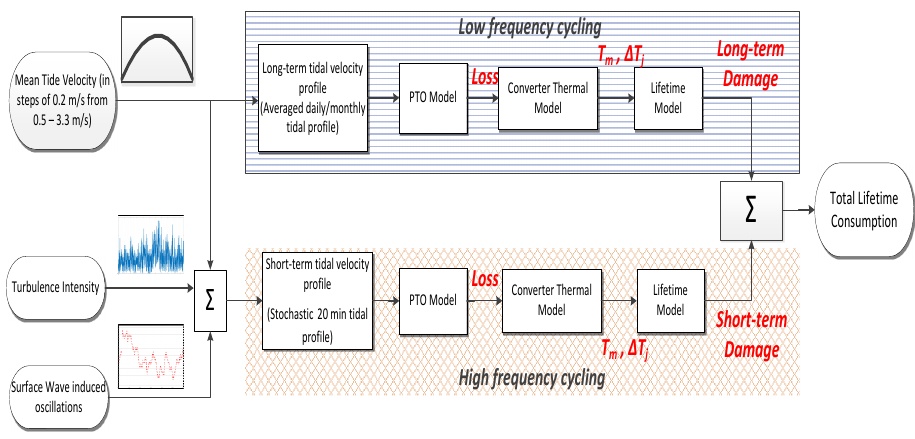
Figure 11. Methodology for lifetime calculations: low and high frequency thermal cycling. Image adapted from